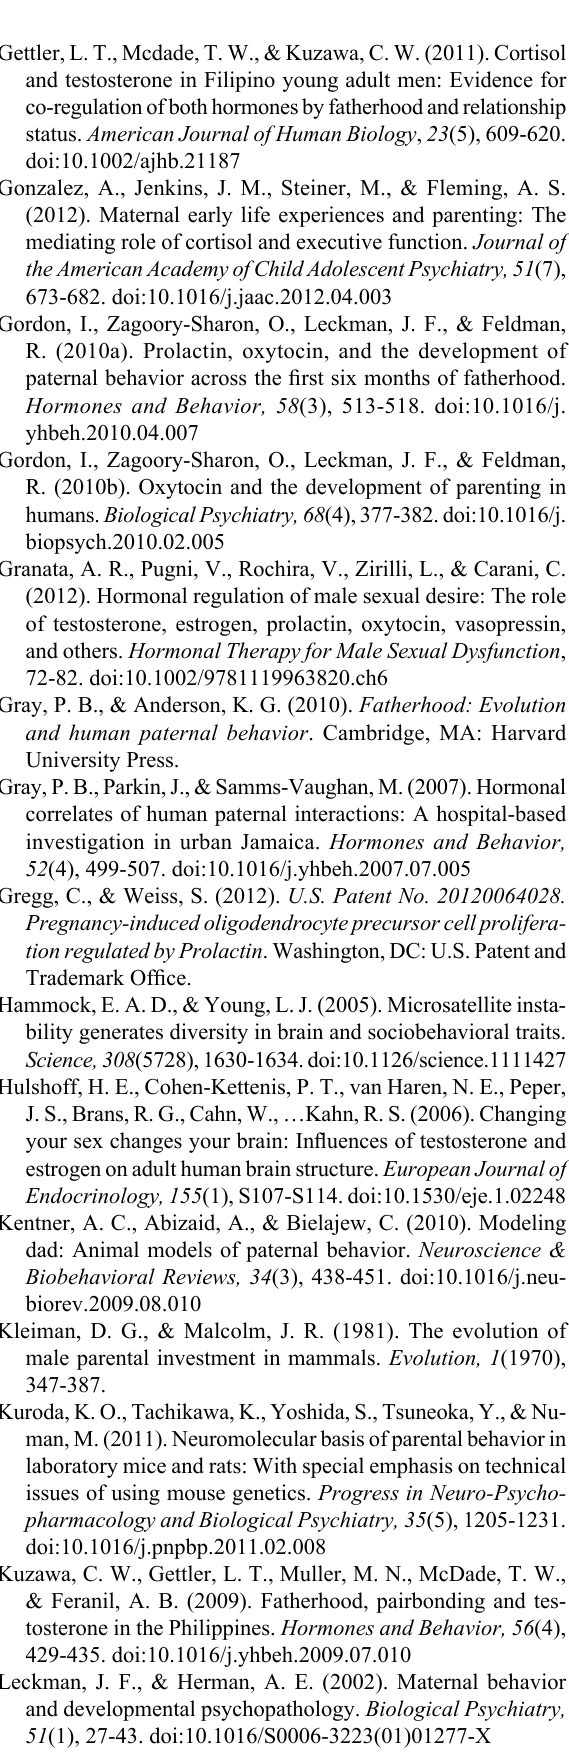
Figueiredo, B. (2004). Depressão na gravidez: Quais as conse- quências para a mãe e o bebé? In I. Leal & C. Faria (Eds.), Psicologia da gravidez e da parentalidade (pp. 23-47). Lisboa, Portugal: Fim de Século. Figueiredo, B., & Conde, A. (2011). Anxiety and depression symptoms in women and men from early pregnancy